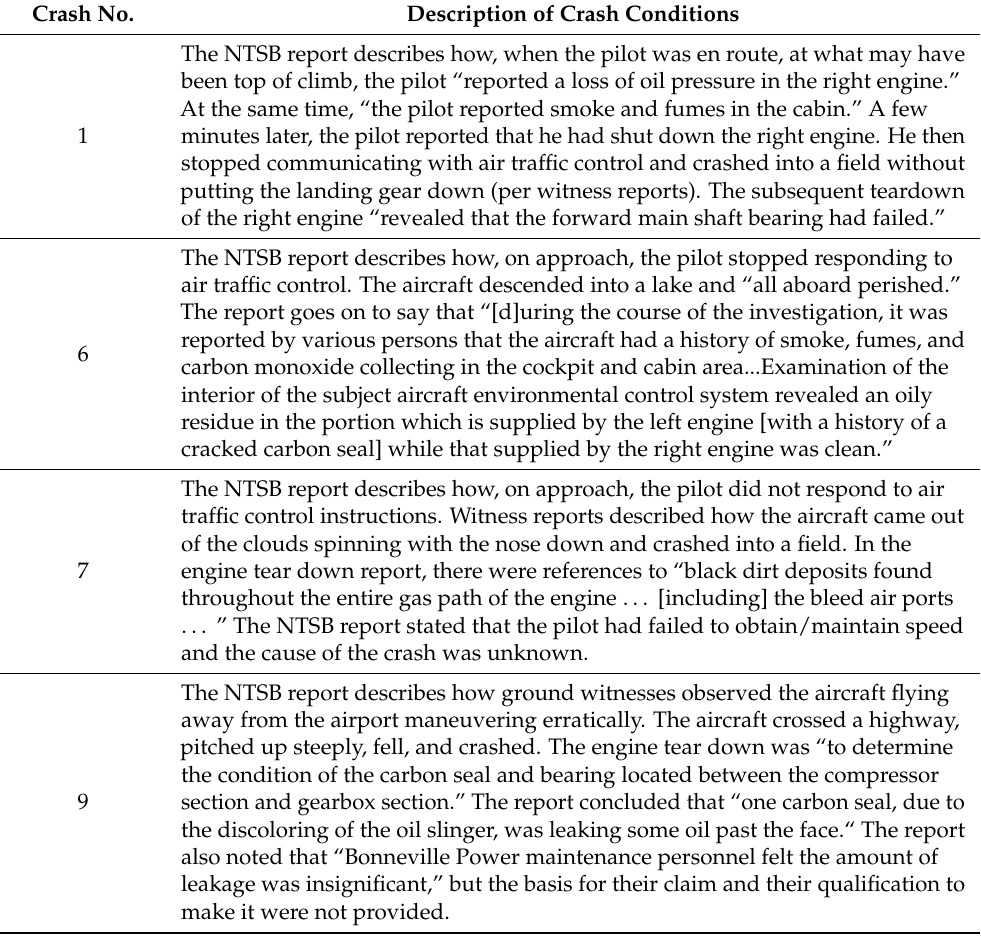
Table 5. NTSB accident report details consistent with exposure to oil